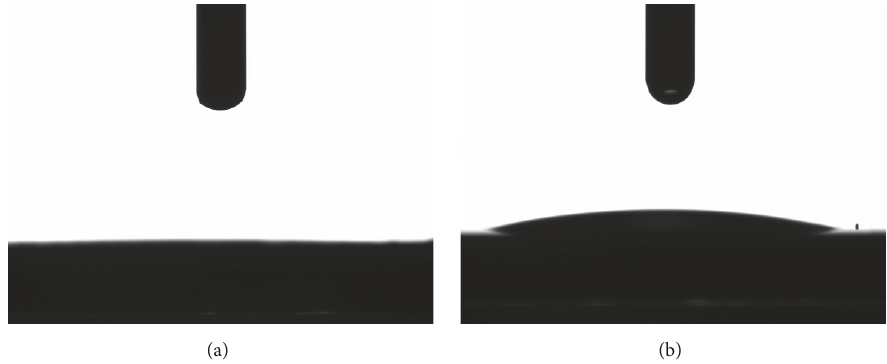
Figure 7: Contact angles of DCPA coatings: (a) freshly prepared; (b) after 4 weeks storage in air.